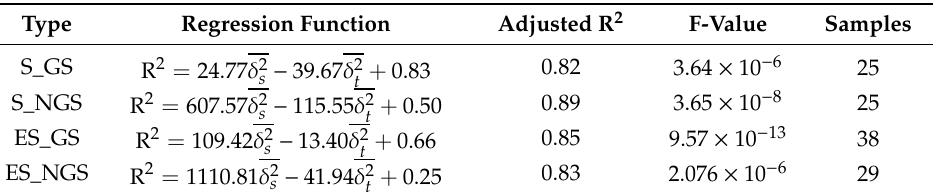
Table 2. Regression equation of spatiotemporal variance and R 2 . S_GS and ES_GS, respectively, represent Spatial and Temporal Adaptive Reflectance Fusion Model (STARFM) and Enhanced STARFM (ESTARFM) in the growing season. S_NGS and ES_NGS represent STARFM and ESTARFM in the non-growing season,